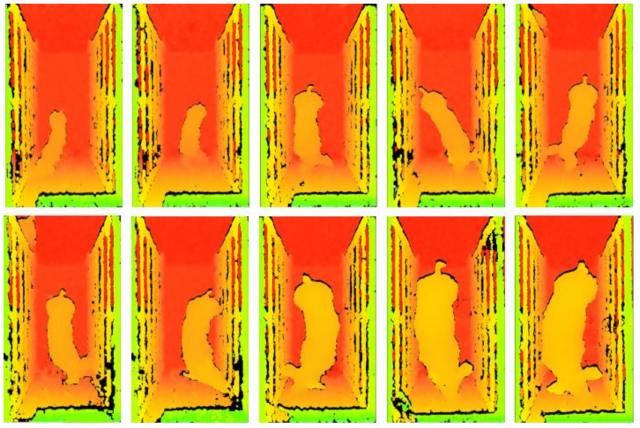
Figure 4. Samples of pig images in various postures. The size of the original 3D images was 1280 × 720 pixels. To improve training speed, all images were preprocessed in the same way (Figure 5). The distance from the depth camera to the weighing platform was 1650 mm, and the pixel value of each point in the original image was the distance in millimeters from the point to the depth camera. To convert this distance to true height, each pixel value in the images was inverted as P i = 1650 − P o (1) where P i represents the pixel’s value in the inverted image, and P o represents the pixel’s value in the original image. After inversion, the pixel value of each point was the distance from the point to the weighing platform in the range of 0–1650 mm. Then, the pixel value of the inverted image was scaled into 0–255 and converted into a gray scale image, where the lighter the color, the greater the height. The gray scale image was then resized into 2 different sizes (299 × 299 pixels and 224 × 224 pixels) as the inputs for different models. Since all images were processed in the same way, the process did not change the relative position and size of the pigs in the images, so it had little impact on the final estimation. Finally, each image was tagged with 6 labels in the order of BW, SW, SH, HW, HH, and